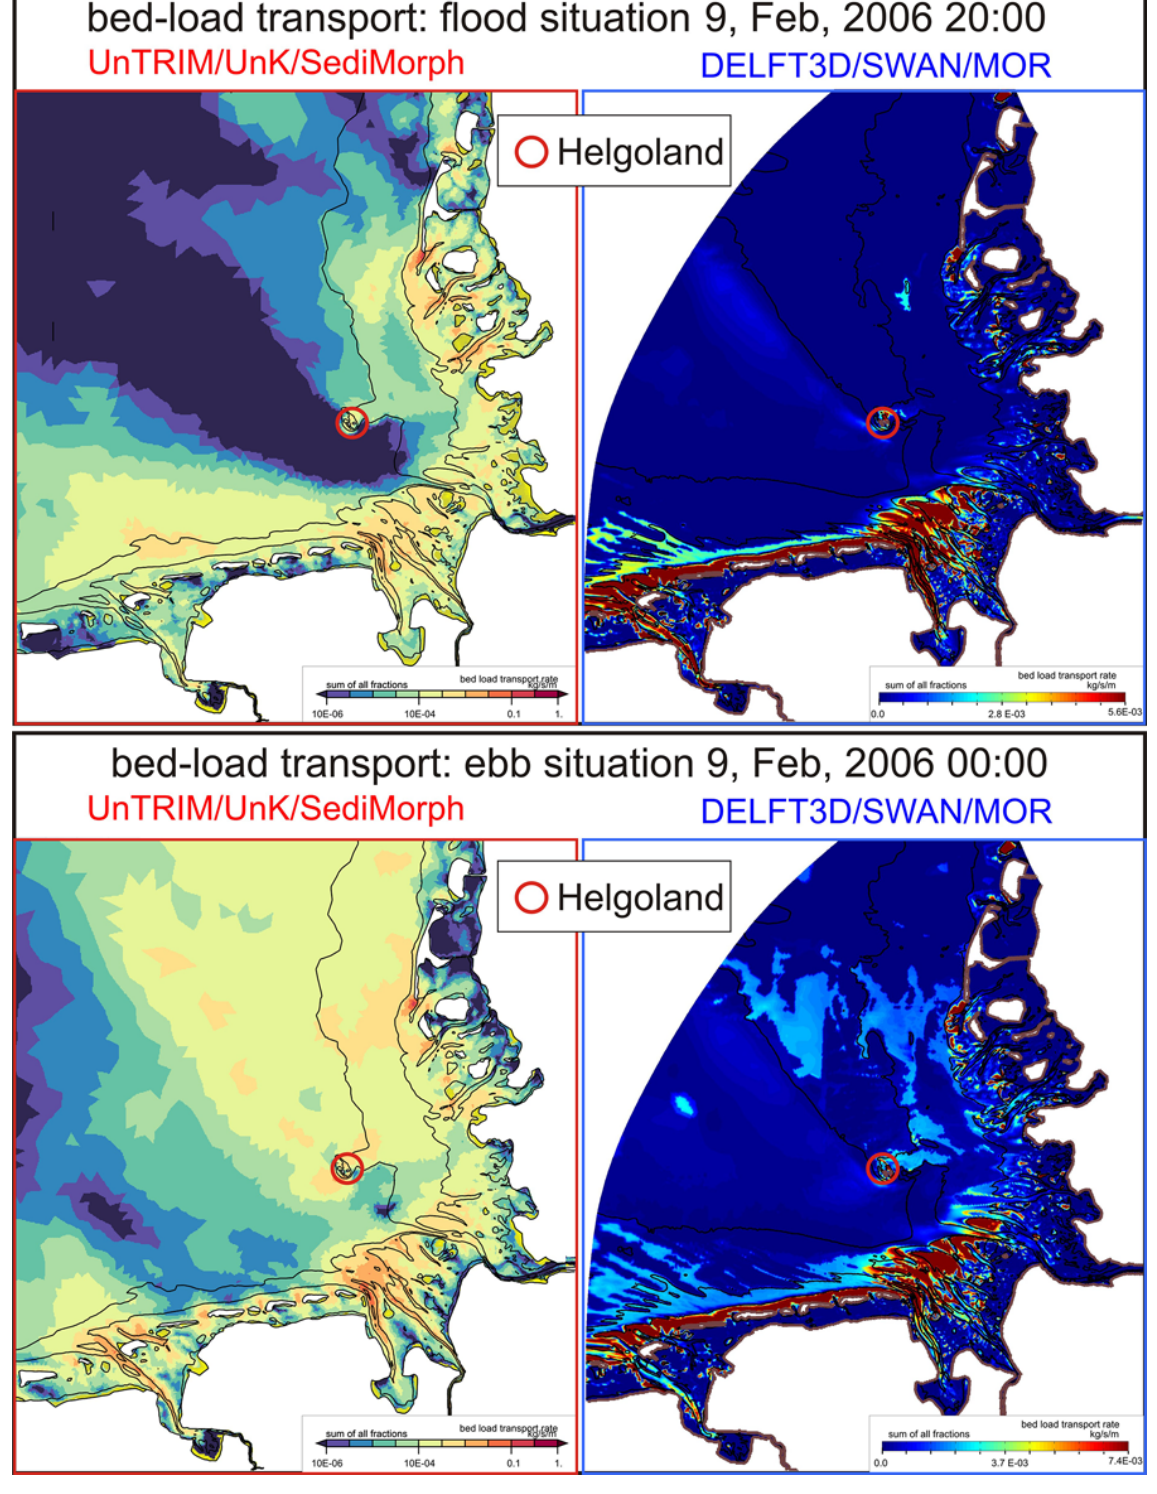
Fig. 3. Bed load transport for windy flood/ebb velocity tide in the German Bight, calculated by UnTRIM/UnK/SediMorph and DELFT3D(2- D